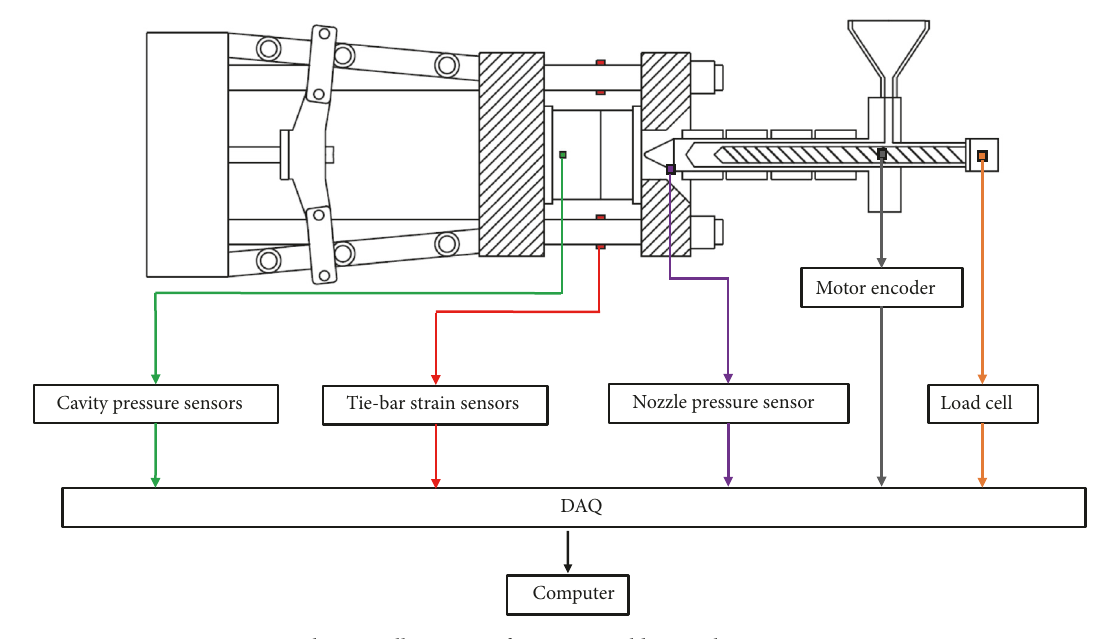
Figure 6: Schematic illustration of injection molding quality monitoring system. Table 5: Sensor specifications.